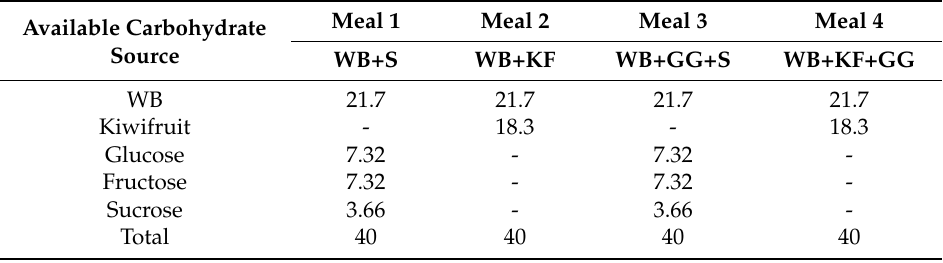
Table 2. Available carbohydrate in meals by formulation